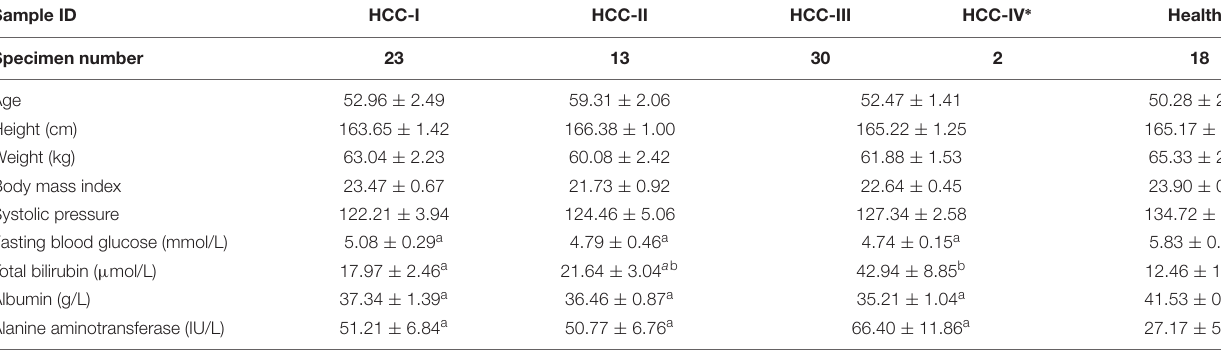
TABLE 1 | Basic and physiological data of patients with primary HCC and healthy